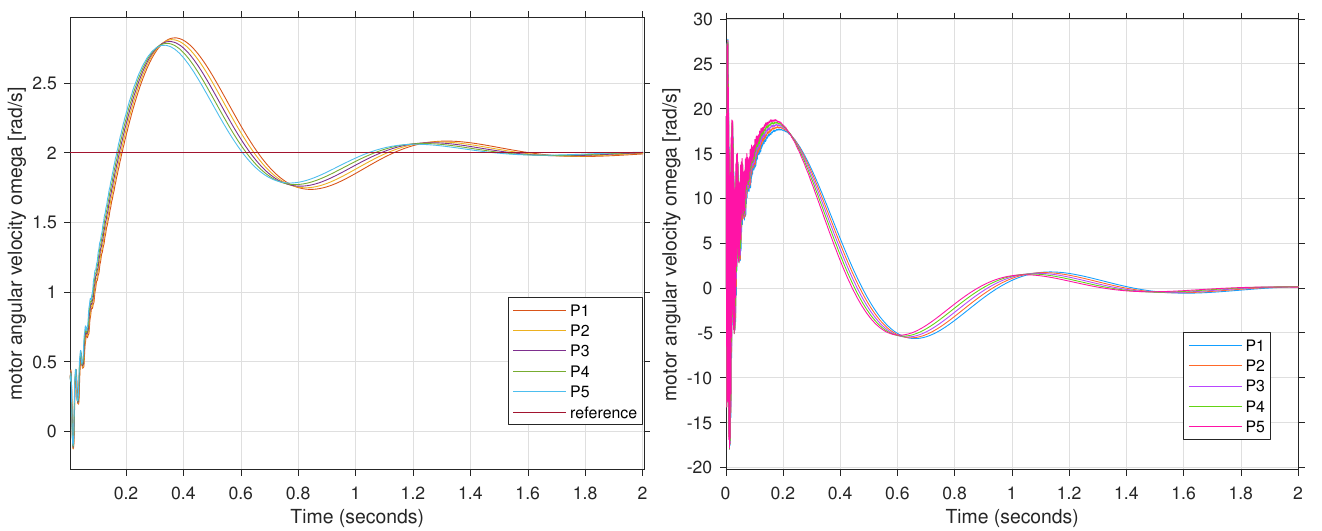
Figure 22. Closed-loop performance achieved with the derived robust controller (47) and the set of five plant models obtained for varying load position (46): reference command following ( left ) and input disturbance rejection ( right